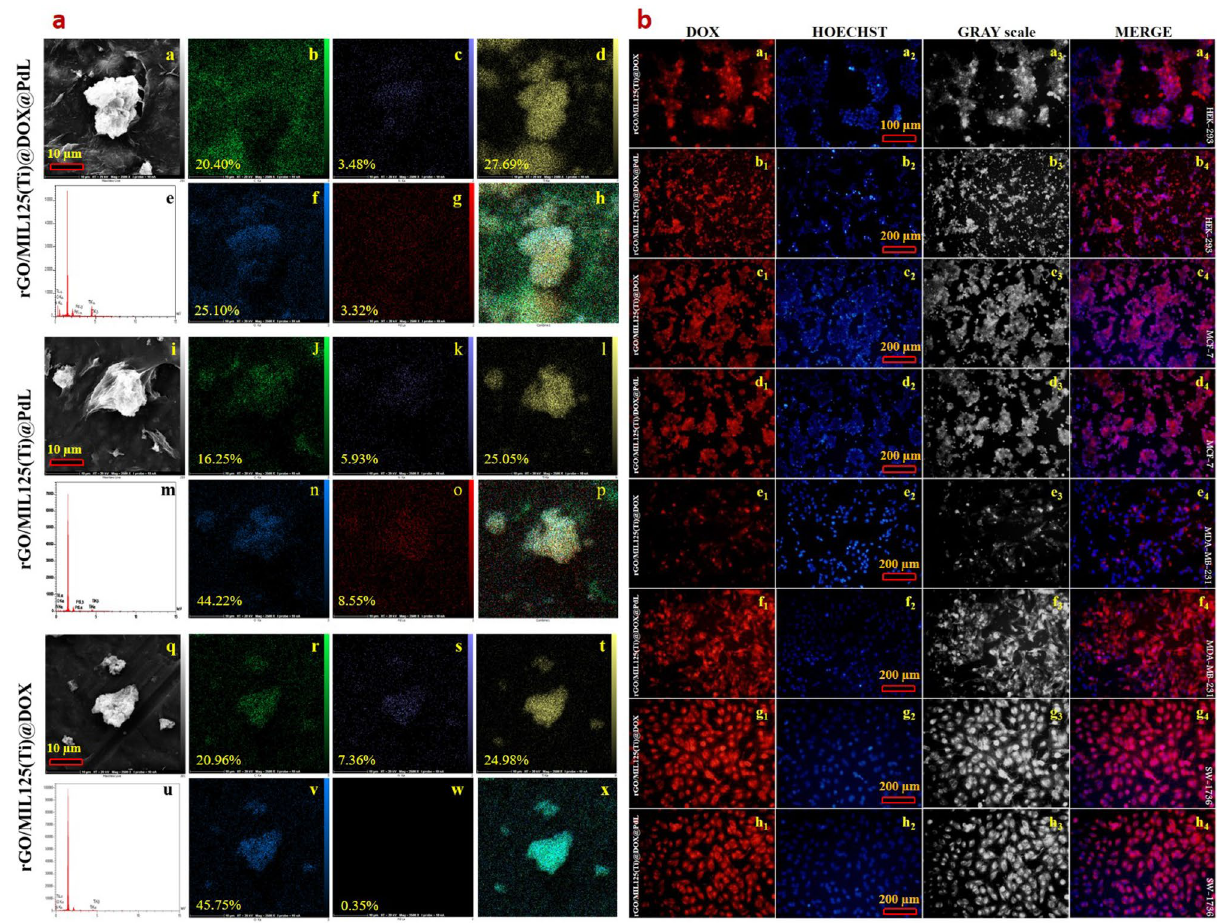
Figure 4. ( a) The EDS and map of rGO/MIL-125(Ti)@DOX@PdL ( a-h ), rGO/MIL-125(Ti)@PdL ( i-p ), and rGO/MIL-125(Ti)@DOX ( q-x ) nanocomposites. (Max view: a, i, and q . Carbon: b, j, and r. Nitrogen : c, k, and s. Titanium: d, l, and t. Oxygen: f, n, and v. Palladium: g, o, and w. Combination: h, p, and x . EDS: e, m, and u ). ( b) Intracellular uptake images of DOX loaded nanocomposites by 2D fluorescence microscopy on HEK-293 ( a and b ), MCF-7 ( c and d ), MDA-MB-231 ( e and f ), and SW-1736 ( g and h ) cell lines (treatment time was 4